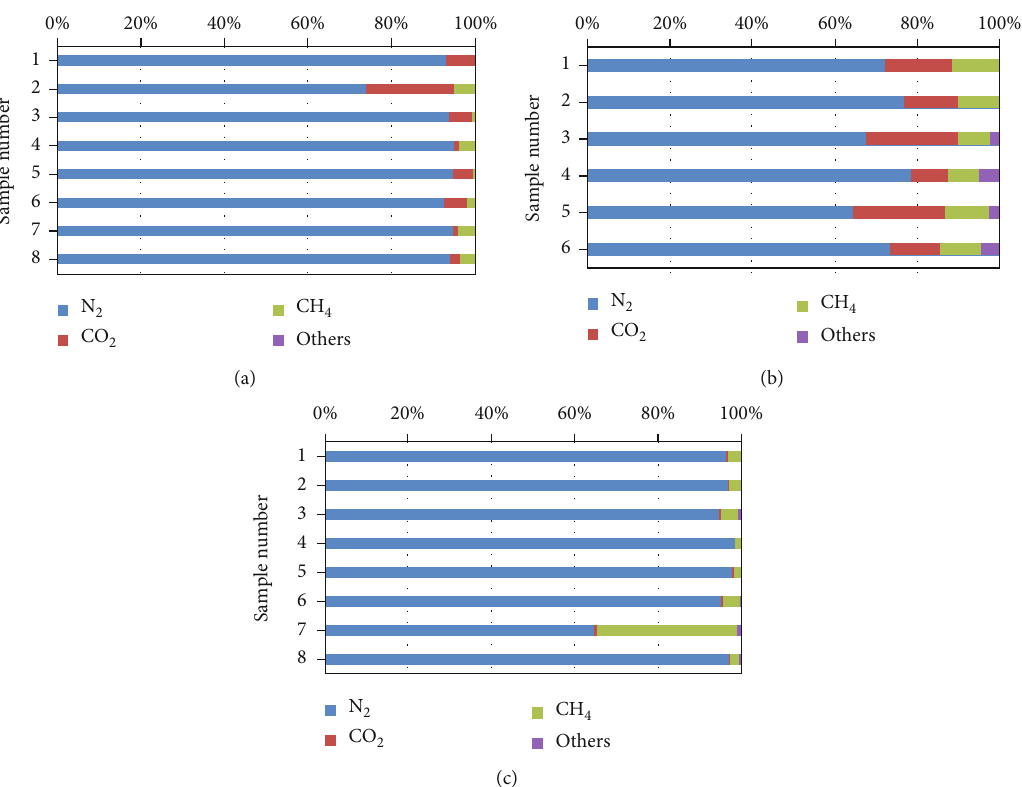
Figure 4: The gas compositions of the Lower Cambrian shale gas reservoirs in southern China. (a) Well YC9 in southeastern Chongqing, (b) Well CY1 in northwestern Hunan, and (c) Well TM1 in northern Guizhou (original data from Jiang et al. [79]; Wang et al. [92]; Jiao et al. [101], see Figure 2 for well